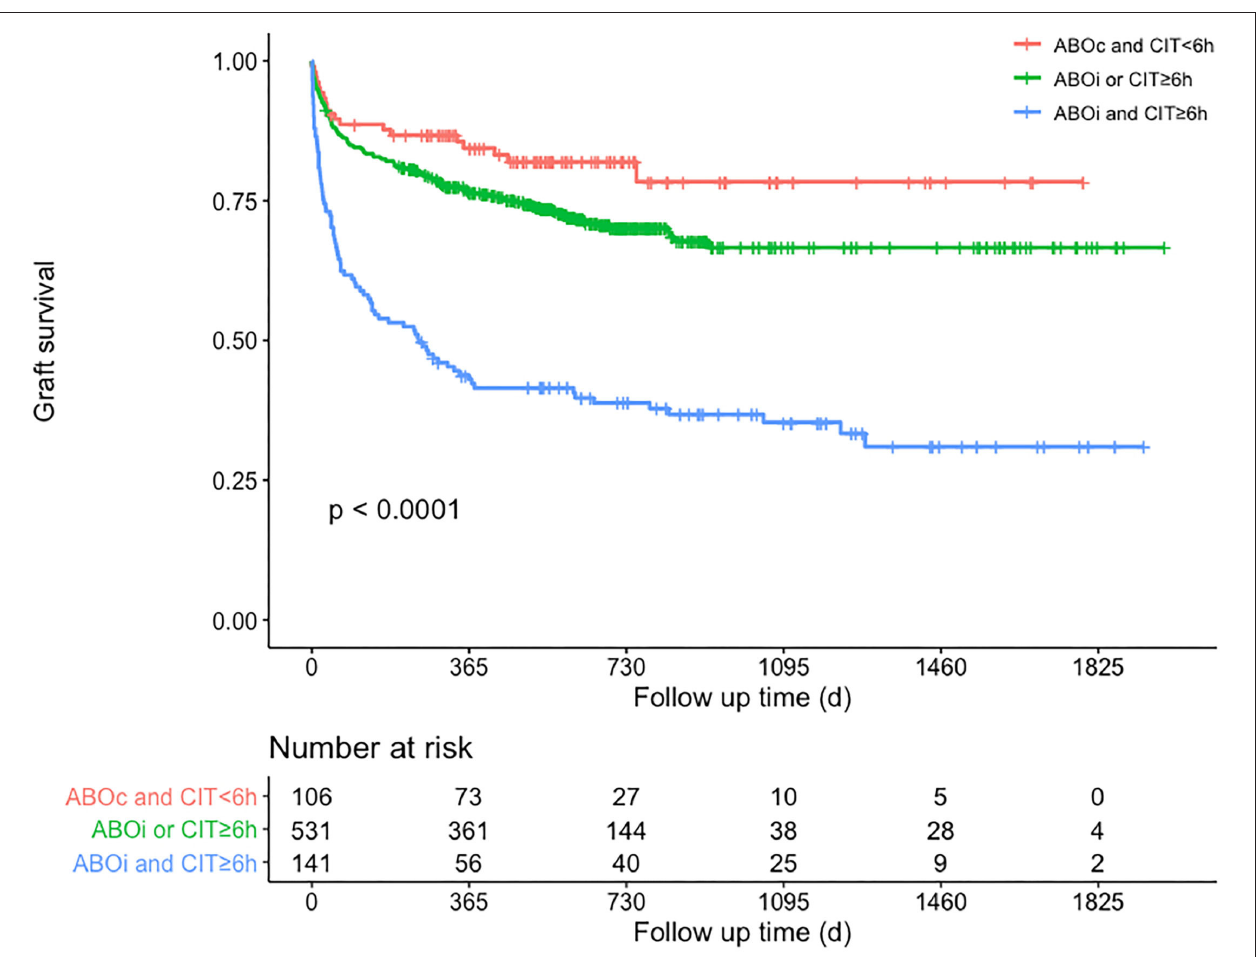
FIGURE 3 | Patients’ graft survival rates according to subgroup analysis of whether CIT is < 6h and ABO blood type is compatible. Comparisons between curves were performed with the log-rank test ( P < 0.01). Red curve means that recipients received ABO compatible and CIT < 6h grafts, green curve means that recipients received ABO compatible and CIT ≥ 6h grafts or received ABO incompatible and CIT < 6h grafts, blue curve means that recipients received ABO incompatible and CIT ≥ 6h grafts. ABOc, ABO-compatible; ABOi, ABO-incompatible; CIT, cold ischemia